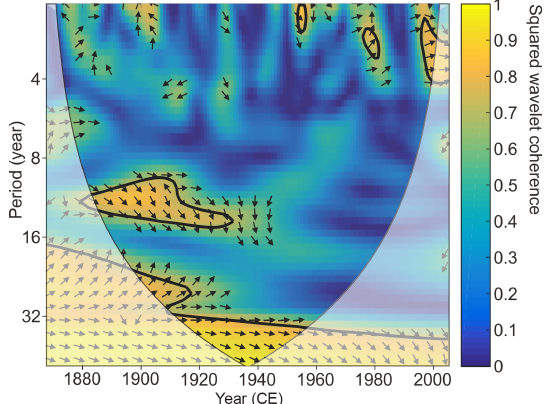
Figure 8. Squared wavelet coherence and phase relationship be- tween the reconstructed MJJ scPDSI and EASMI (Zhao et al., 2015). The color bar indicates the squared wavelet coherence. The arrows indicate the phase relationship with in-phase (anti-phase) pointing right (left) and EASM leading (lagging) scPDSI with 90 ◦ pointing straight up (down). The thick contour indicates the 5% sig- nificance level against red noise. The cone of influence (COI) where edge effects might distort the picture is marked in a lighter